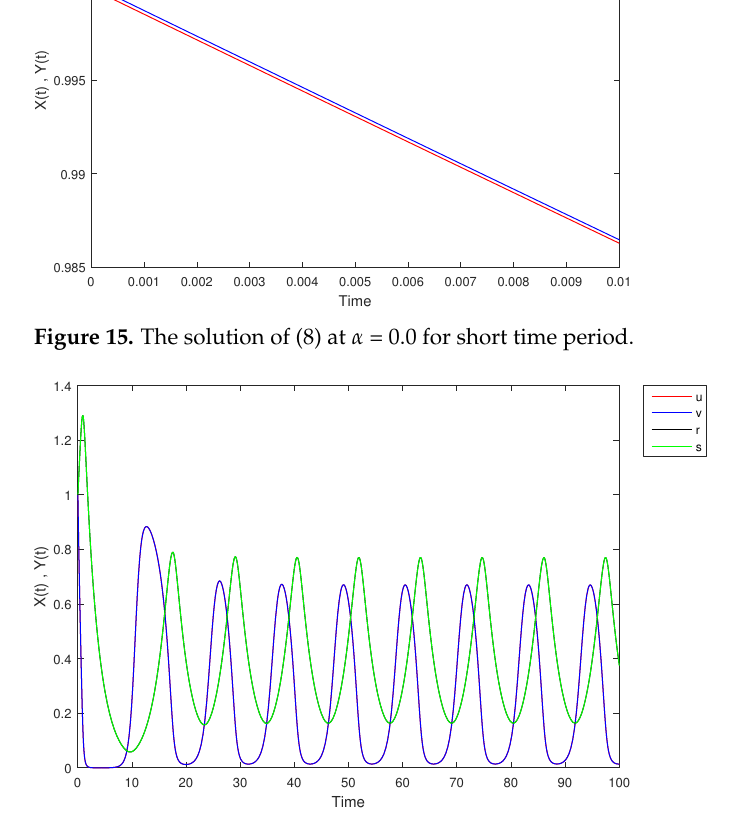
Figure 16. The solution of (8) at α = 0.0 as time